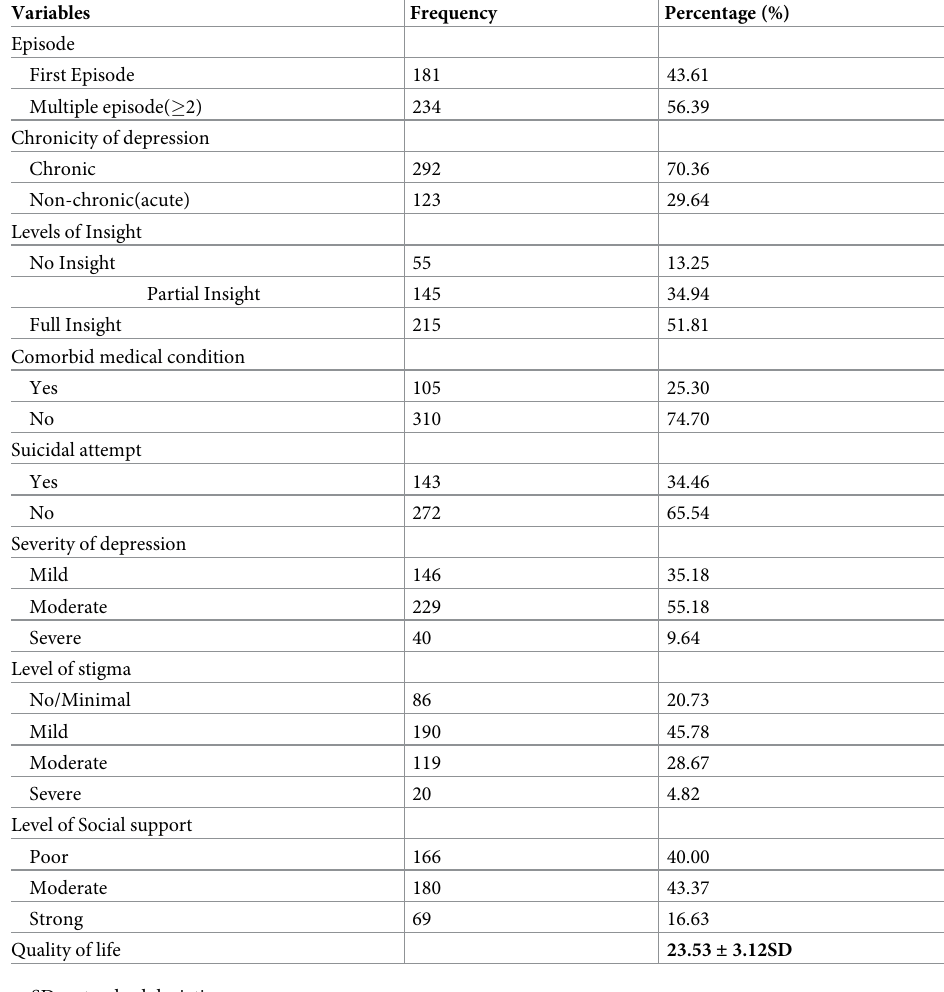
Table 2. Clinical characteristics of the study